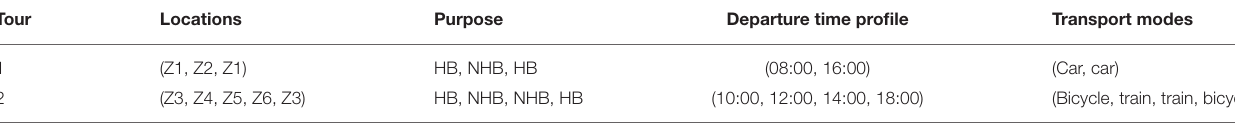
TABLE 2 | Sample of the observed tours from the Open PFLOW dataset.